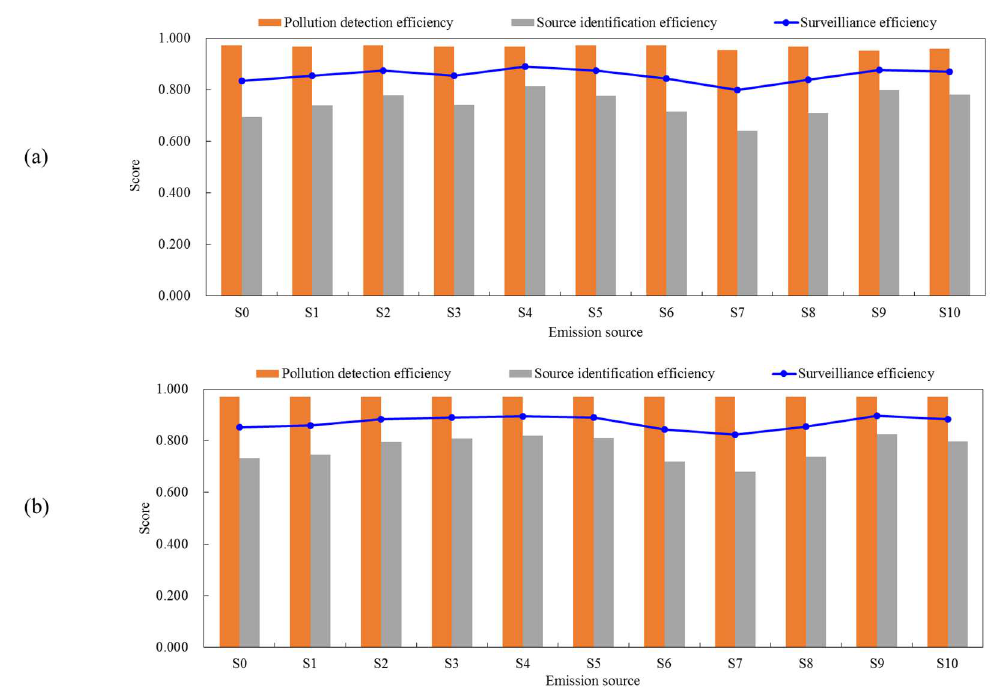
Figure 9. The performance of the optimal distribution of the AQMN for Scenario II. The numbers of monitors are ( a ) 64 and ( b ) 110.